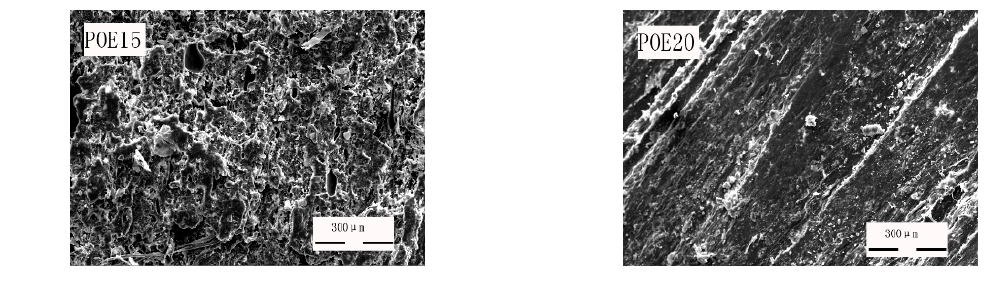
Figure 7. SEM images of the broken impact sections.